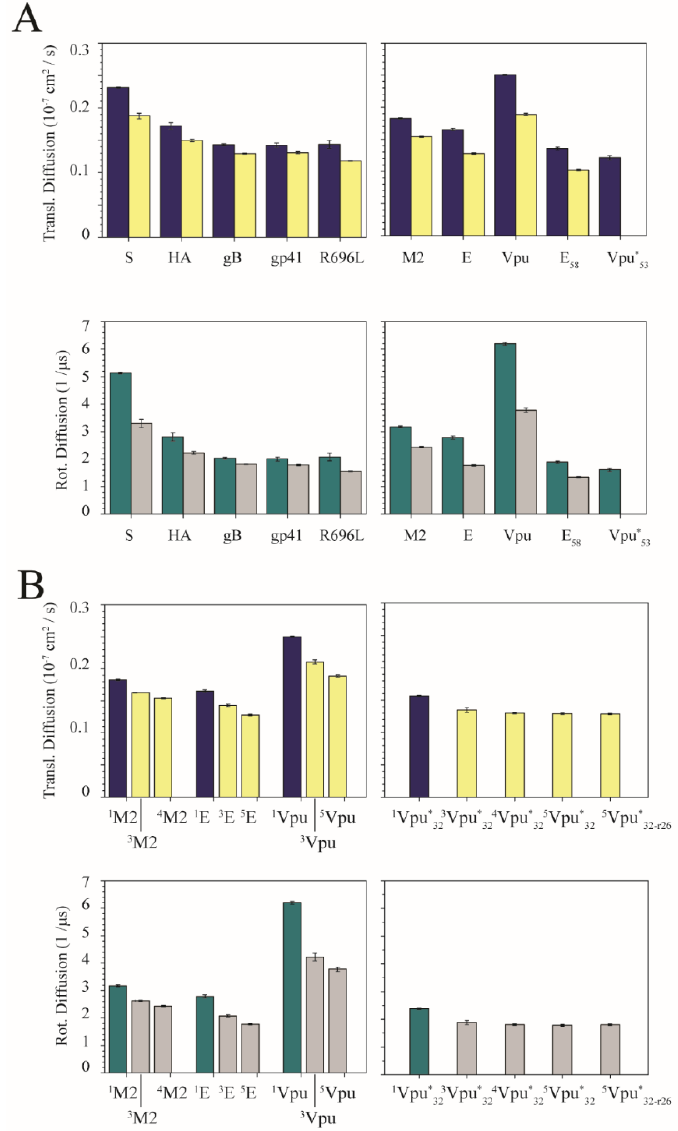
Figure 3. ( A ) Translational (upper panel) and rotational diffusion coefficients (DCs) (lower panel) of fusion (left column) and channel peptides (right column) from MD simulations of the experimental structures. The data are calculated using lpp. The blue and green bars represent the data for the simulations of the monomers, while the yellow and grey bars represent the data of the oligomers (3 TMDs for each fusion protein; 4 TMDs for M2, and 5 TMDs for E and Vpu proteins). The subscripts for Vpu and E protein mark the number of amino acids used in the simulation. The star in Vpu* 53 indicates that this structure is derived from an ideal helix (see Materials and Methods). ( B ) DCs for specific oligomeric structures using the same calculation (lpp) and color scheme as above. Left column shows the DCs of experimental ion channel peptides in monomeric and tetra-/pentameric states together with trimeric conformations, which are done by using the in-house software Prediction of Ion Channel Assemblies (PICA), by taking experimental monomers as building blocks for the assembly. Right column shows the PICA-generated oligomeric bundles by using the ideal monomeric structure of Vpu. The superscripts mark the oligomeric state which was used in the simulations. For 5 Vpu* 32 , the tryptophan residues are pointing inside the pore, while r26 marks the respective pentameric bundle, 5 Vpu* 32-r26 , which the tryptophan residues are pointing to outside the bundle leaving the S24 pointing inside the putative pore. This kind of orientation also appears in the trimeric and tetrameric